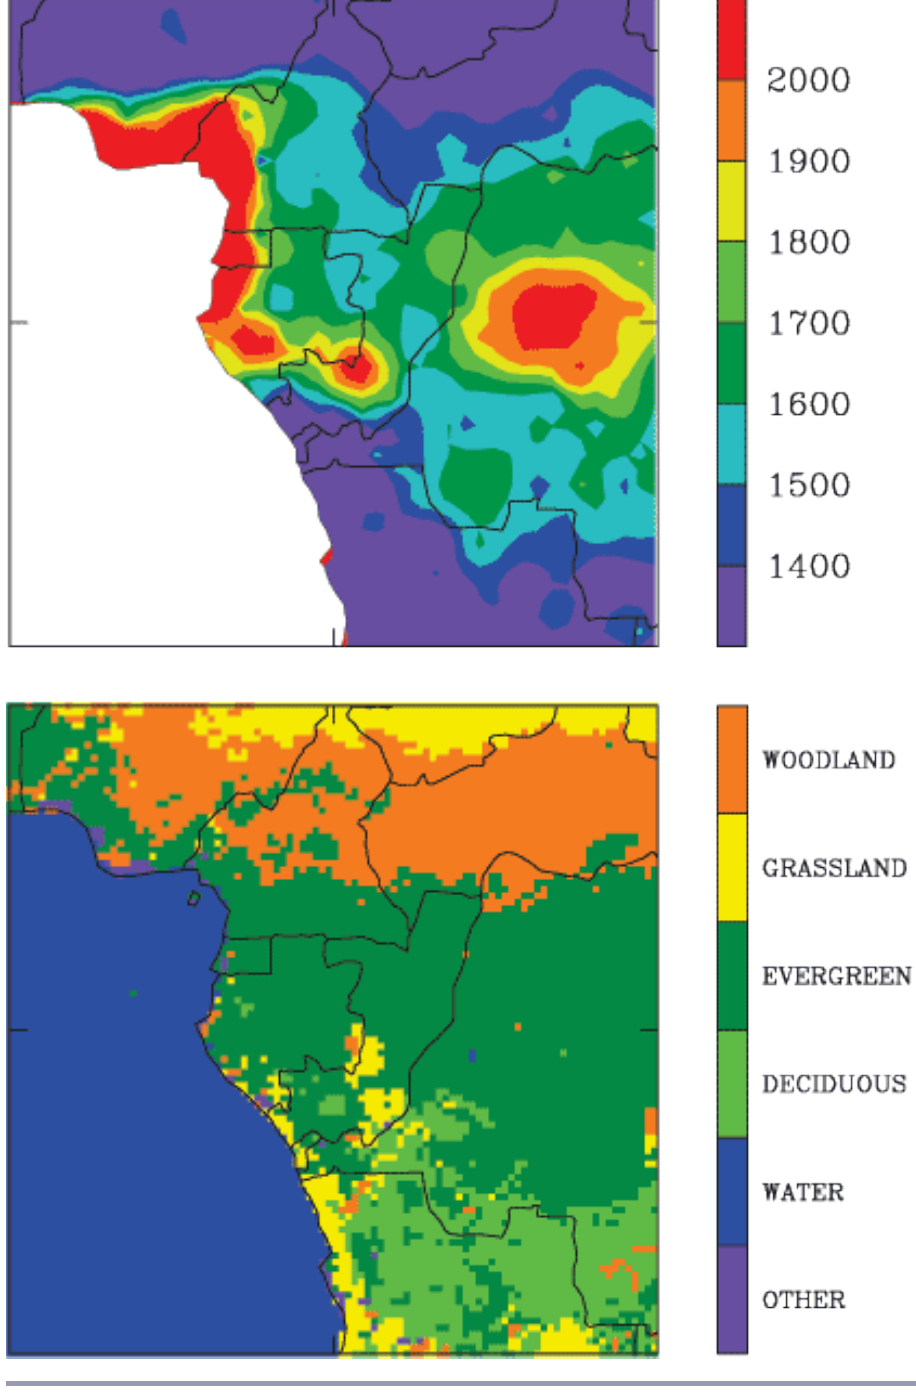
Fig. 1 . Mean annual precipitation (mm) for western equatorial Africa (top) based on Wilmott and Matsuura (2000) and vegetation types in western equatorial Africa (bottom) based on Olson